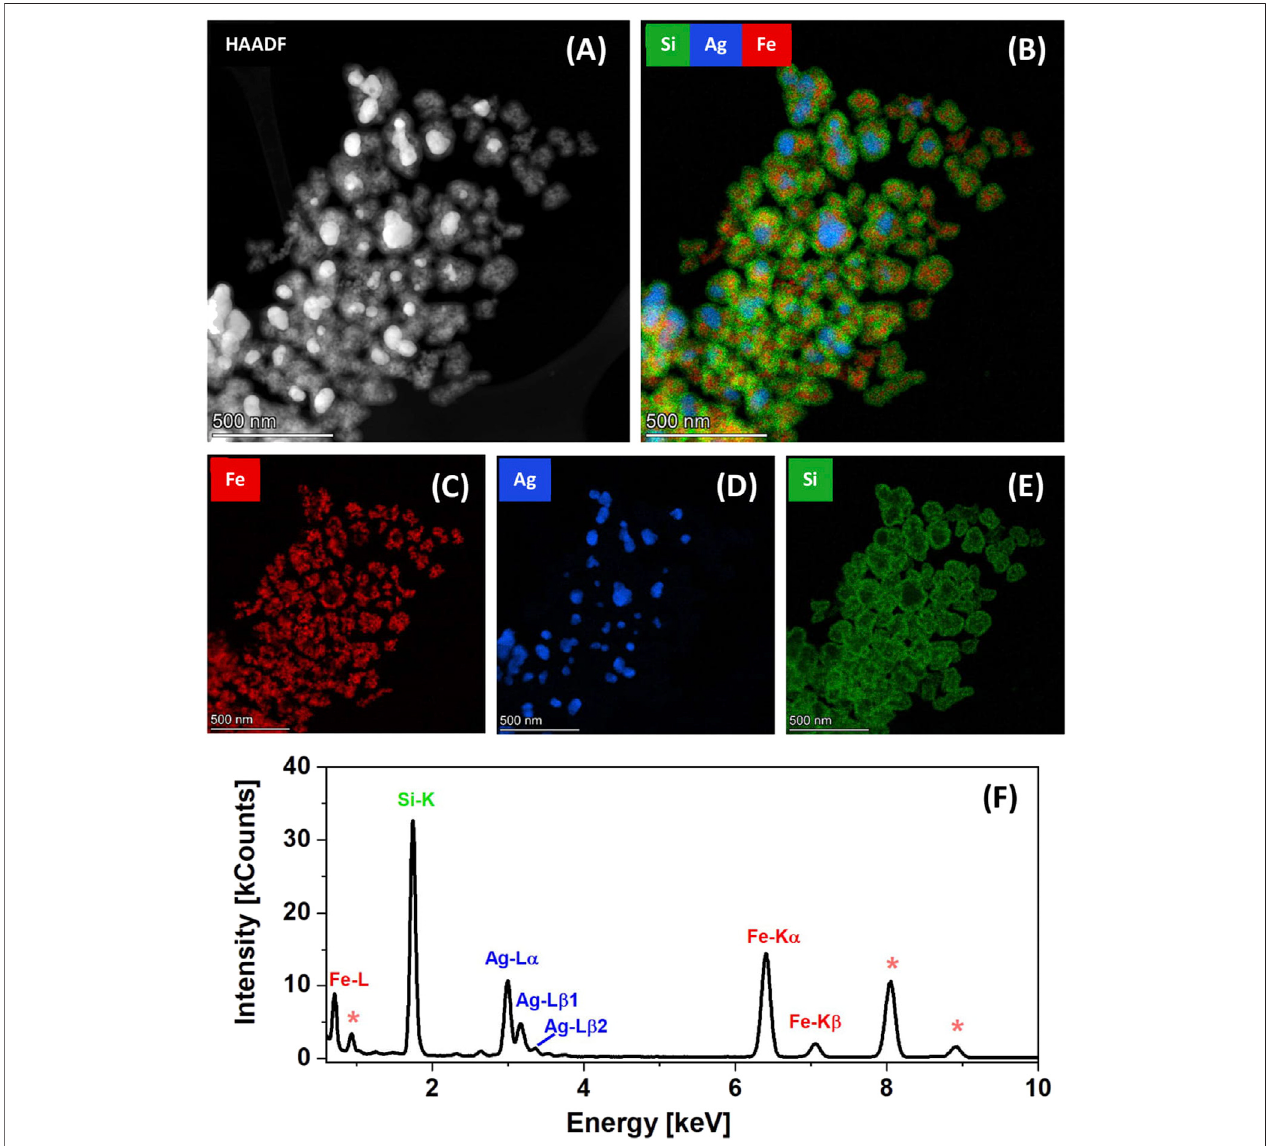
FIGURE 3 | Nanostructural characterization and chemical composition of Fe 3 O 4 /Ag@MES@SiO 2 nanocomposite: (A) STEM-HAADF and corresponding (B – E) STEM-EDX elemental mapping images showing the distribution of respectively overlay of Fe+Ag+Si and individual Fe, Ag and Si, with the (F) EDX spectrum representative for the area scanned to acquire image presented in part (A) ; signals from the Cu grid are marked with asterisks.